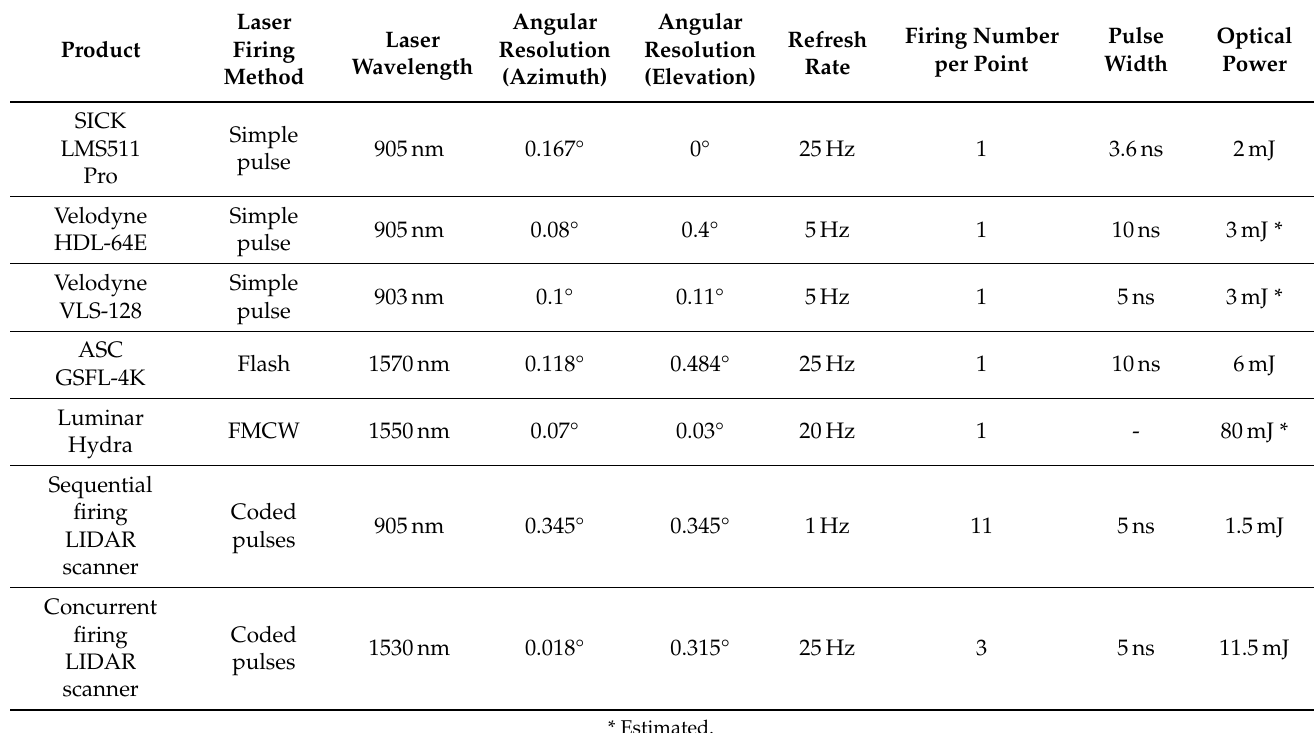
Table 4. Emitted laser power comparison of representative LIDARs.